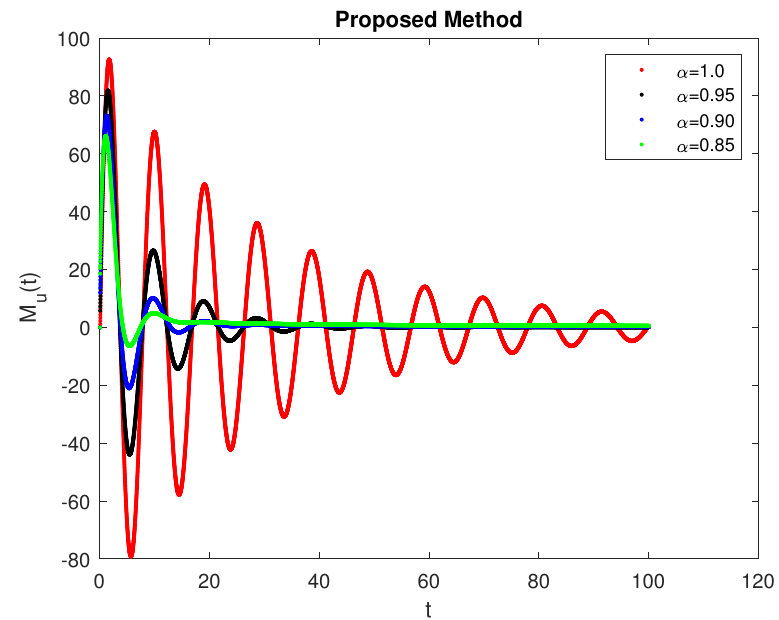
Figure 7: Numerical simulations for τ = 0.98 for ABC derivative.